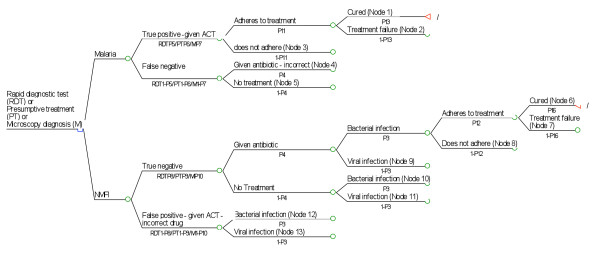
Root decision tree.